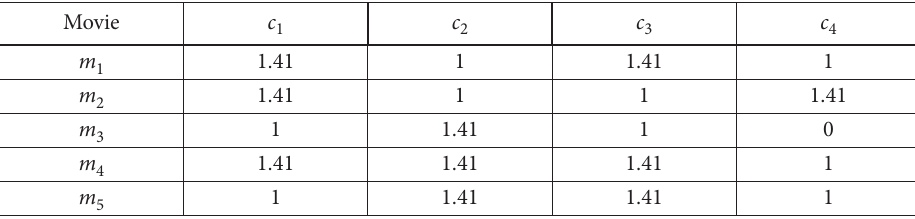
Table 3. Variance function decision matrix